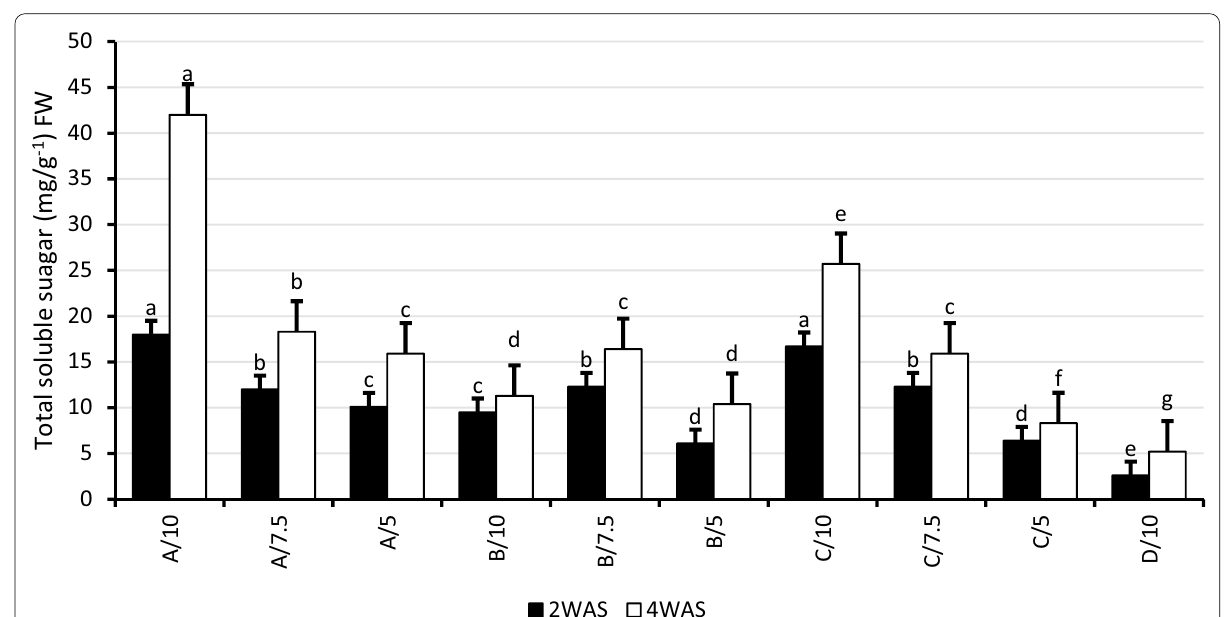
Fig. 5 Total soluble sugar contents of rice seedlings at 2 and 4 weeks after sowing. Results with similar alphabets on same bars did not differ from each other ( p >0.05).